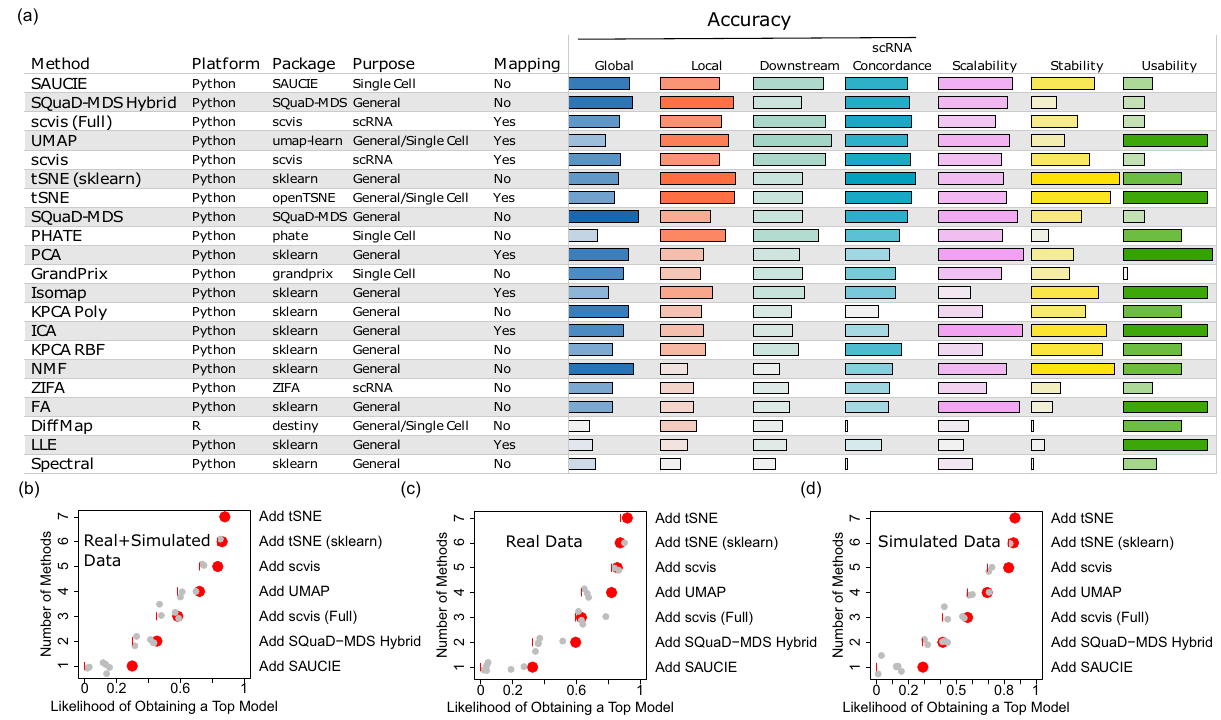
Fig.2|Overviewofthemainresultsofthisbenchmarkstudy.a TheDRmethods reviewed in this study, their basic characteristics described in text, and their per- formancesintermsofaccuracy,scalability,stability,andutility.Resultsforthereal and the simulationdata wereaveraged for each ofthe four sub-categories. The DR methods were ranked based on the overallaccuracy, averaging across allfour sub- categories. All bars shown are calculated using ranks. Darker shaded bars within each column correspond to the better performance and therefore longer bars. Different colors are used to distinguish between different categories. Com- plementarity of the DR methods, evaluated on the real+simulated CyTOF datasets